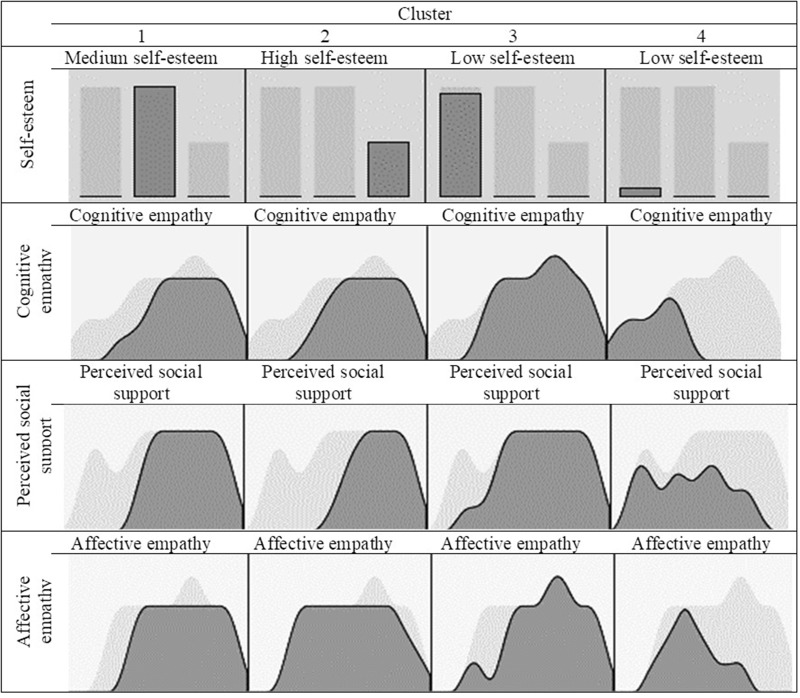
Cluster composition.